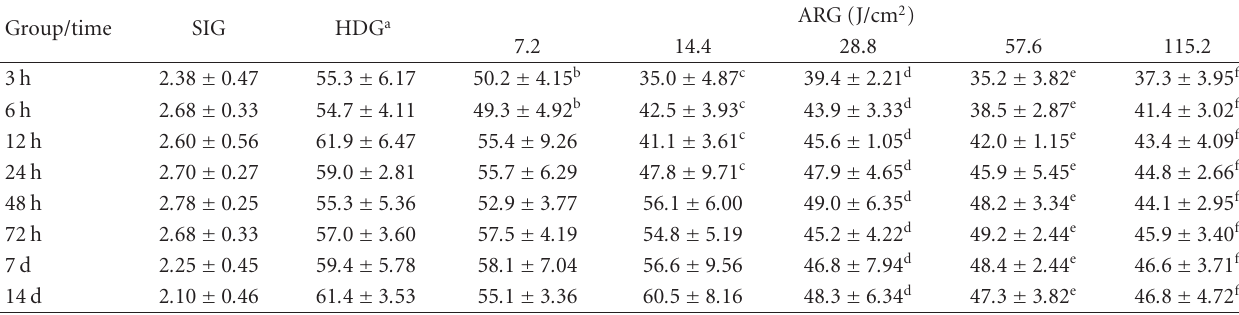
Table 3: E ff ects of lethal irradiation on fibroblast apoptosis after UVA preirradiation at di ff erent time intervals ( x ± S %, n = 4). Group/time